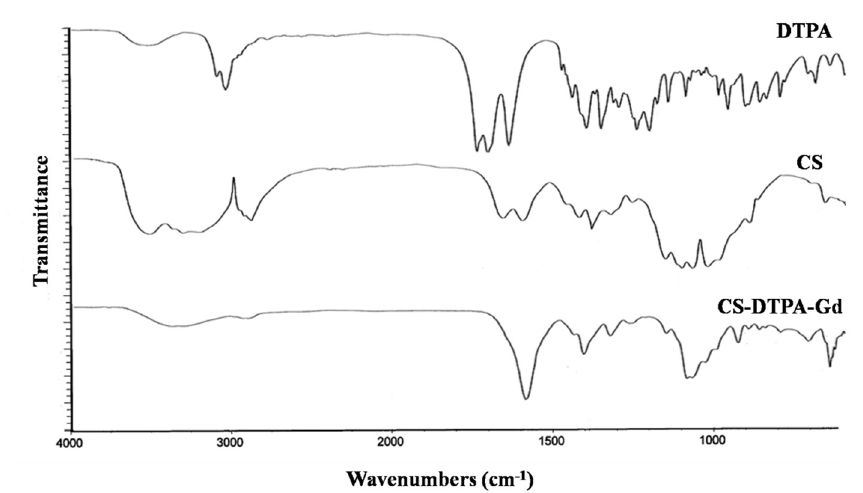
Figure 3. FTIR spectra of DTPA, CS and